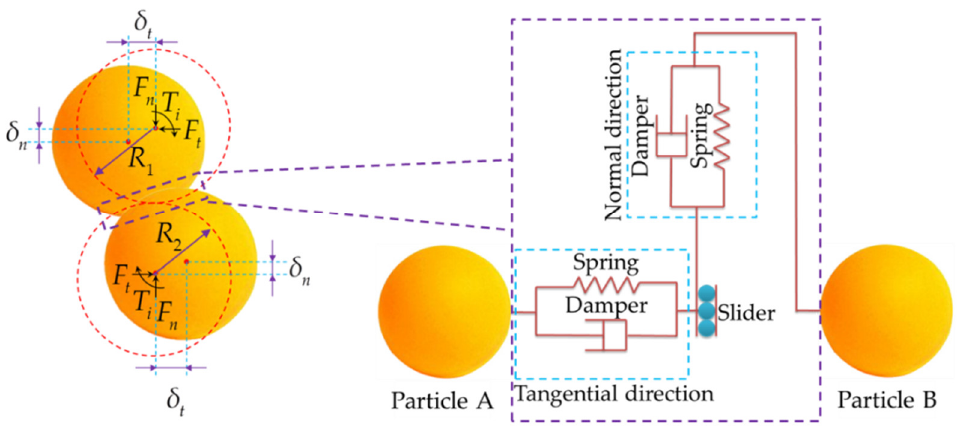
Figure 3. Mechanical contact model: The red dotted lines show the positions of particles A and B without considering the force; yellow particles represent the state after